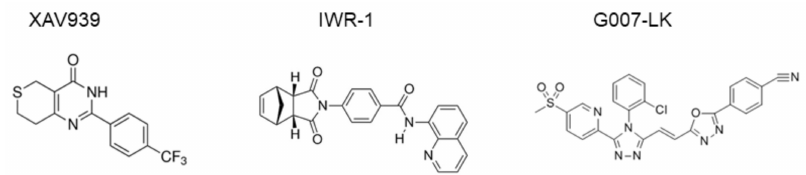
Figure 2. Structure of tankyrase inhibitors showing the structures of XAV939, IWR-1, and G007-LK